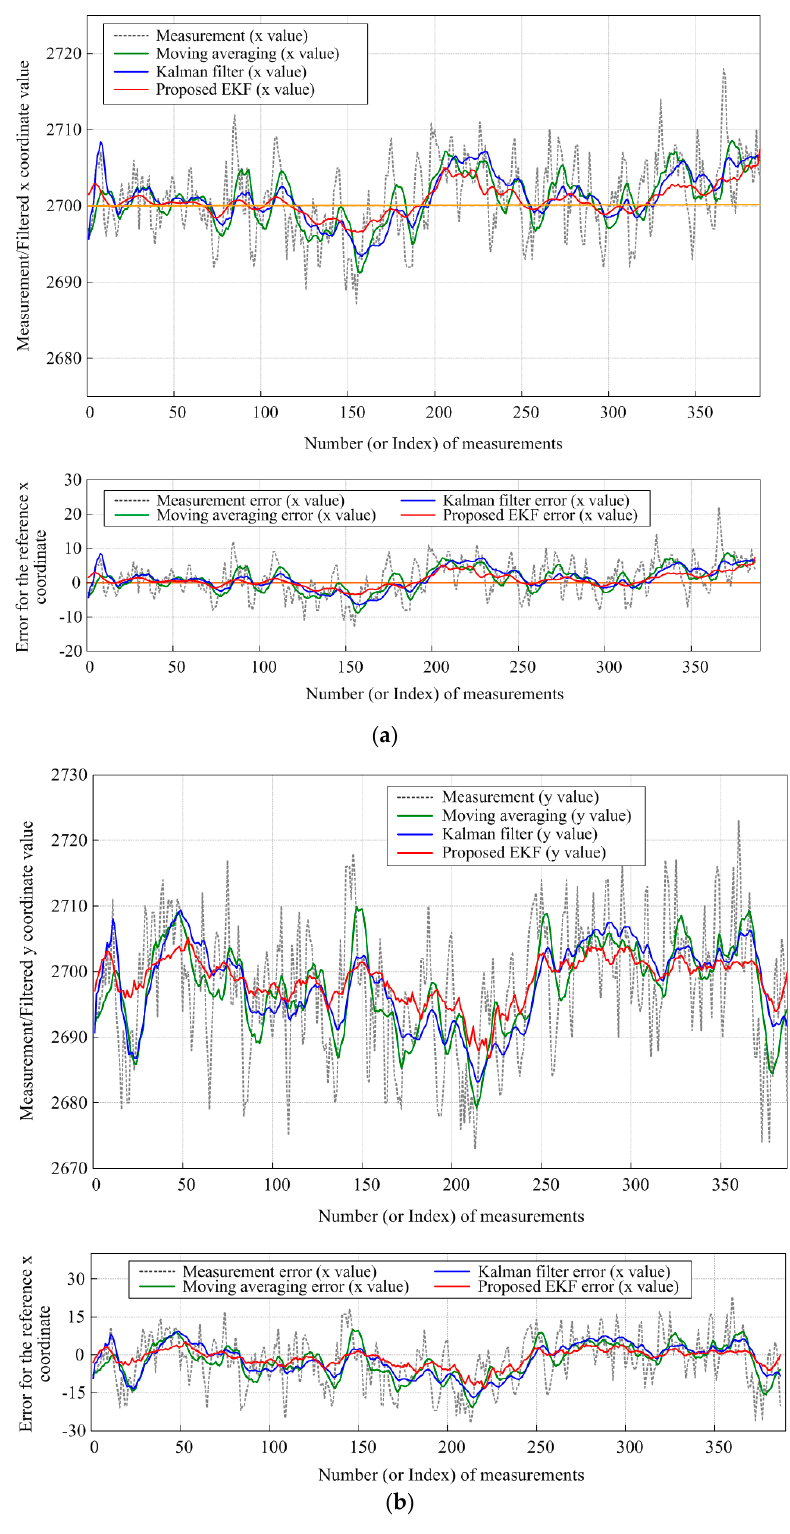
Figure 10. Measurement results and error for the reference coordinate (2700,2700) using Moving Average filter (green line), Kalman filter [7] (blue line), and proposed EKF (red line) for ( a ) x-axis and ( b ) y-axis.